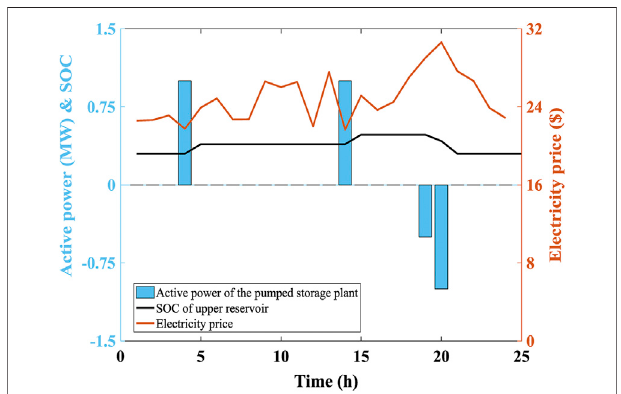
FIGURE 6 | Active power of the pumped storage plant.